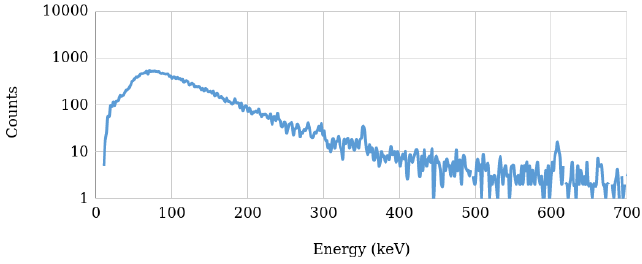
Figure 29. Spectrum acquired with the CZT at the background level, in Scenario C. The acquisition time was approximately 32